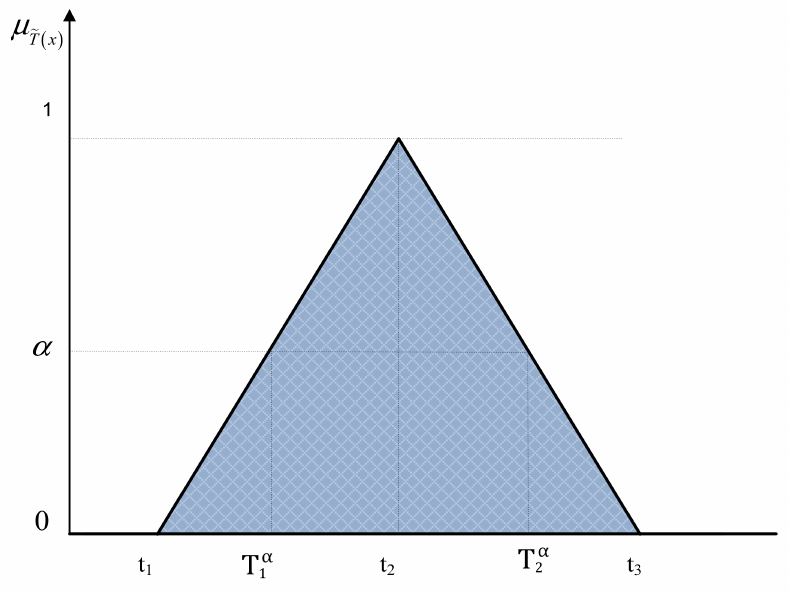
Figure 2. Triangular fuzzy number